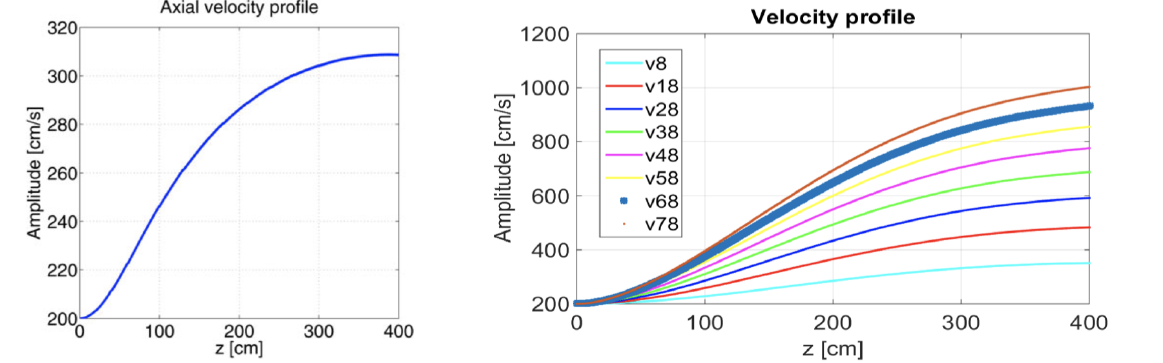
Figure 2: Void velocity profiles simulated by a Monte-Carlo model of bubbly two-phase